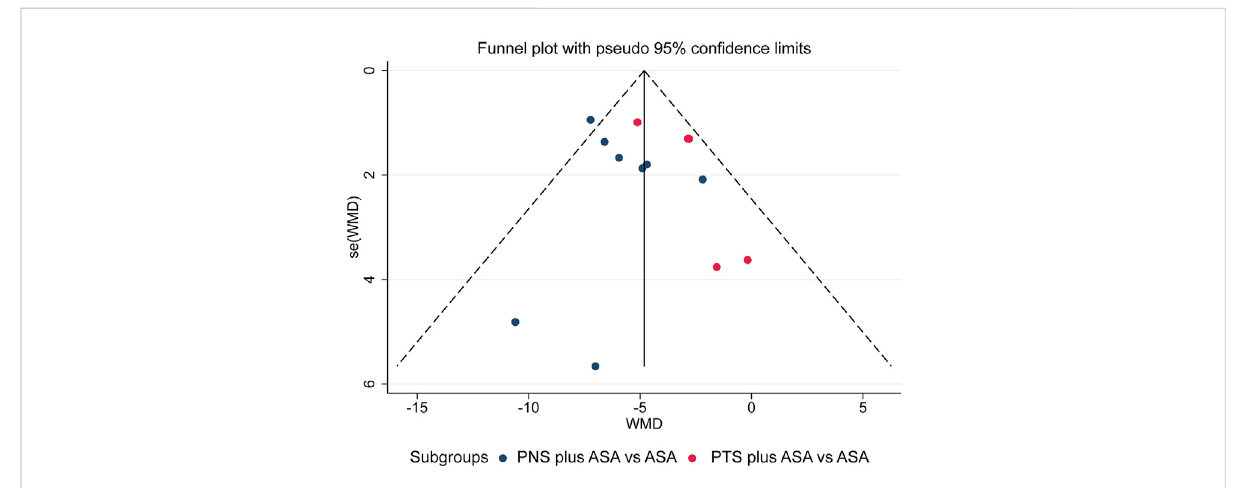
FIGURE 7 Funnel plot of comparison of PAgR between PNS plus ASA group or PTS plus ASA group and ASA group. PAgR, platelet aggregation rate; PNS, Panax Notoginseng Saponins; ASA, aspirin; PTS, Panaxatriol